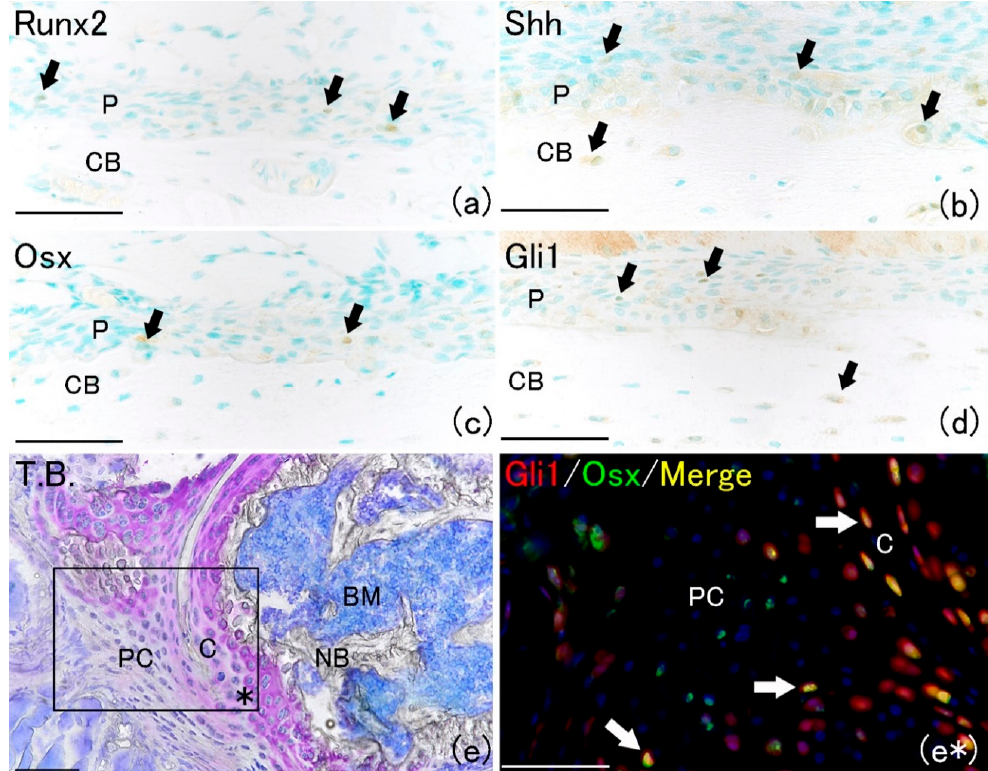
Figure 1. Histological analysis at day 0 on rat lib bone and at day seven on mouse lib bone fracture. ( a ) Runx2-positive cells were rarely observed at the surface of bone matrix in the periosteum (arrows). Scale bar: 50 μ m. ( b ) Shh-positive expression was observed at the surface of bone matrix and osteocyte (arrows). Scale bar: 50 μ m. ( c ) Osx-positive cells were rarely observed at the surface of bone matrix in the periosteum and same localization as Runx2. Scale bar: 50 μ m. ( d ) Gli1-positive expression was observed at the surface of bone matrix and osteocyte and same as Shh localization (arrows). Scale bar: 50 μ m. ( e ) Cross section pictures of fracture site. Newly formed cartilage matrix was observed around new bone and bone marrow. Scale bar: 100 μ m. ( e* ) Gli1-positive cells were observed in perichondrium and formed new cartilage at the fracture site (red fluorescent cell). Osx-positive cells were localized around the new cartilage matrix (green fluorescent cell). The merged image of Gli1- and Osx-positive areas demonstrated that the most Osx-positive cells merged on Gli1-positive cells (arrows). Scale bar: 50 μ m. (P: periosteum; CB: cortical bone; PC: perichondrium; C: cartilage; NB: new bone; BM: bone marrow).